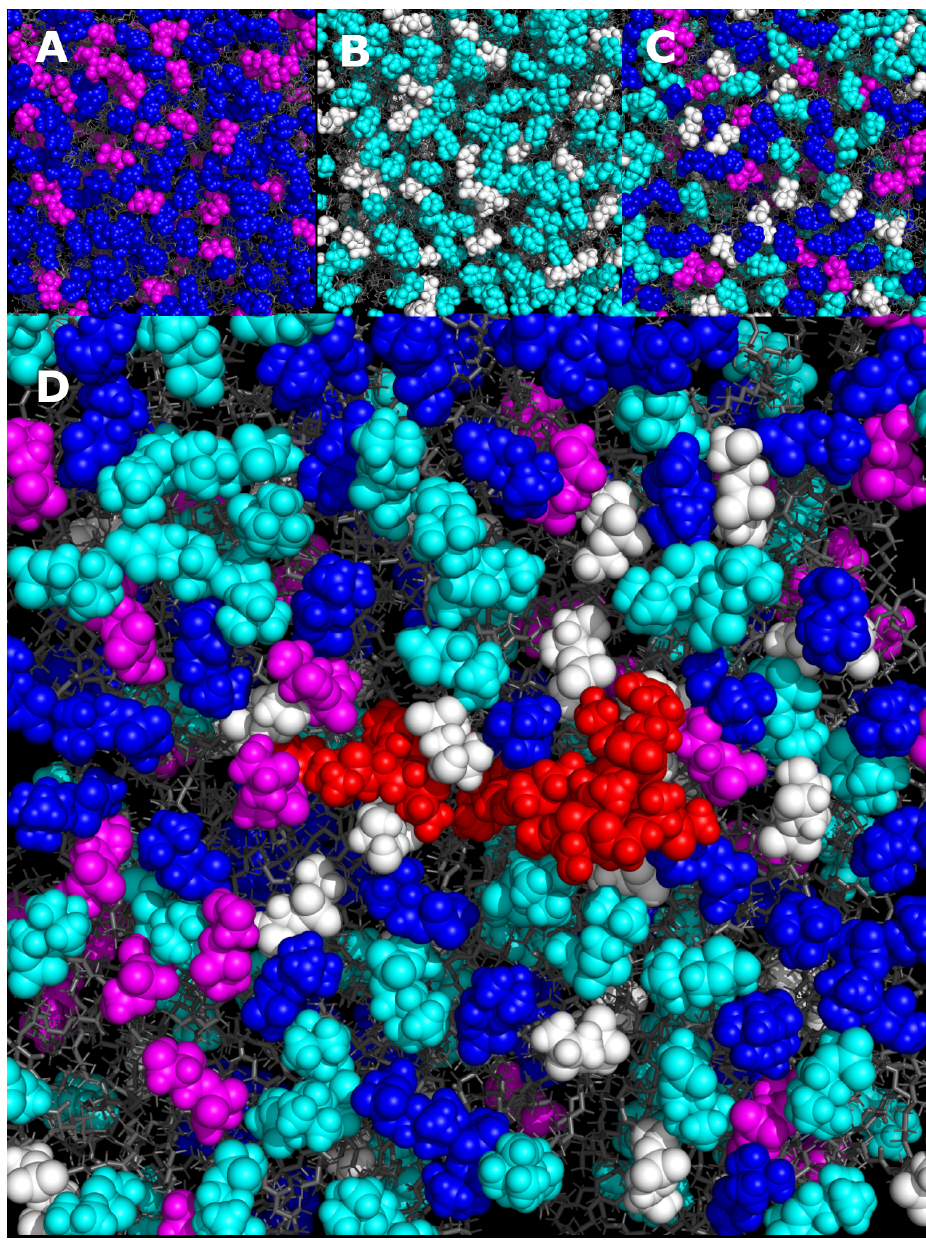
Figure 6. Snapshots of the MD simulations performed for ( A ) Lipid-1, ( B ) Lipid-2 and ( C ) Lipid-3 and ( D ) gp41rk/Lipid-3. Atoms within the HGs of the lipids are shown as colored spheres, while the rest of each lipid molecule is presented as grey sticks. In the images, DMPC is blue, DMPG is magenta, POPC is cyan and POPG is white. The gp41rk in ( D ) is red. The images were rendered using PyMOL